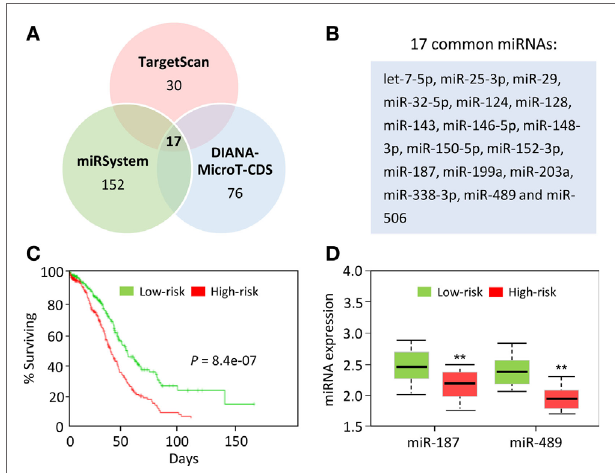
FigURe 2 | MicroRNAs (miRNAs) that potentially regulate B7H3 expression in ovarian cancer. (A) Venn diagram showing the overlap of miRNAs that were predicted to bind to the B7H3 3 ′ -UTR by alternative algorithms (TargetScan, miRSystem, and DIANA-MicroT-CDS). (B) The 17 predicted miRNAs were common to these three algorithms. (C) The Kaplan–Meier survival curves of 458 TCGA (Cancer Genome Atlas database) ovarian cancer samples were created using the SurvMicro database based on the low ( n = 229) or high ( n = 229) risk for a poor outcome. (D) Box plots demonstrating significantly lower levels of miR-187 and miR-489 expression in the high-risk ovarian cancer